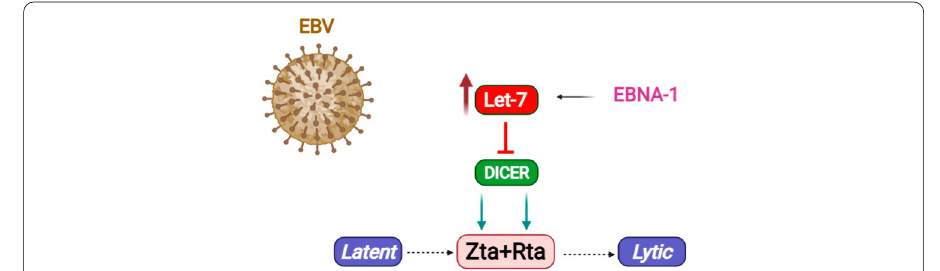
Fig. 2 Hsa‑let‑7b promotes the latency phase of EBV infection by downregulating